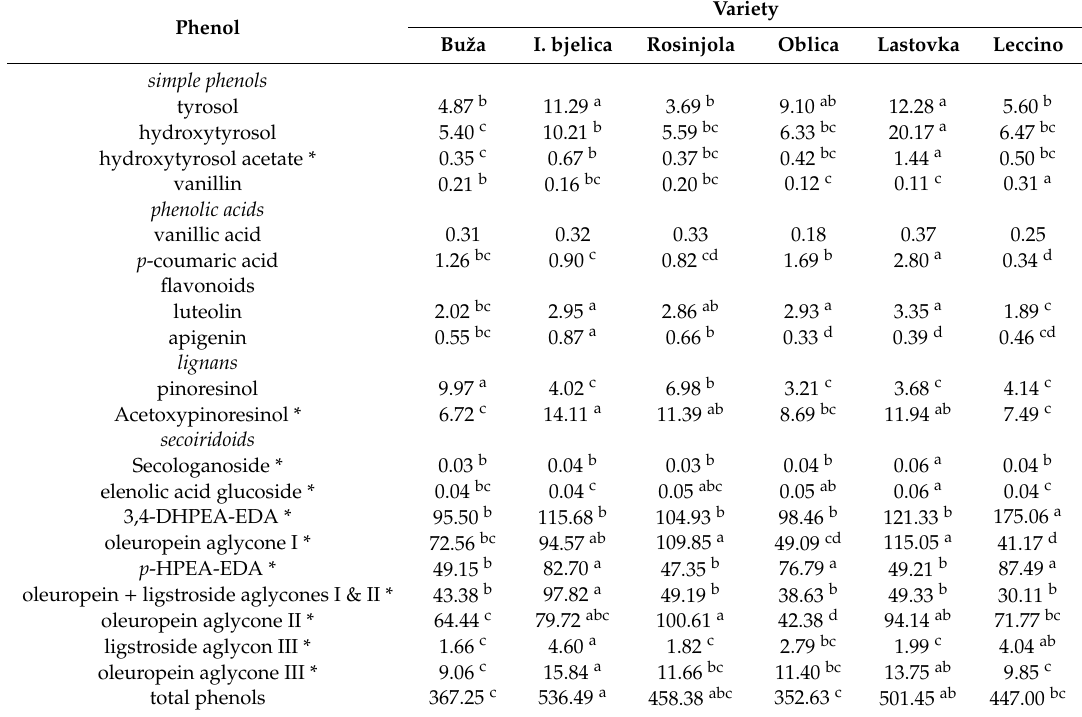
Table 3. Concentrations (mg / kg) of phenols determined by ultra-performance liquid chromatography with diode-array detection (UPLC-DAD) in monovarietal extra virgin olive oils produced from Buža, Istarska bjelica, Rosinjola, Oblica, Lastovka, and Leccino varieties in Croatia.